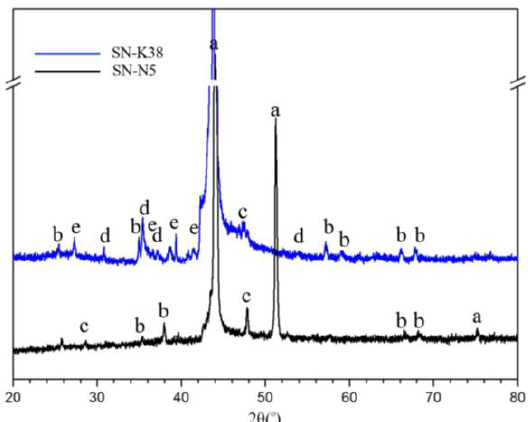
Figure 7. XRD patterns of nanocrystalline coatings after oxidation at 1050 °C for 200 h (a. γ/γ′, b. α-